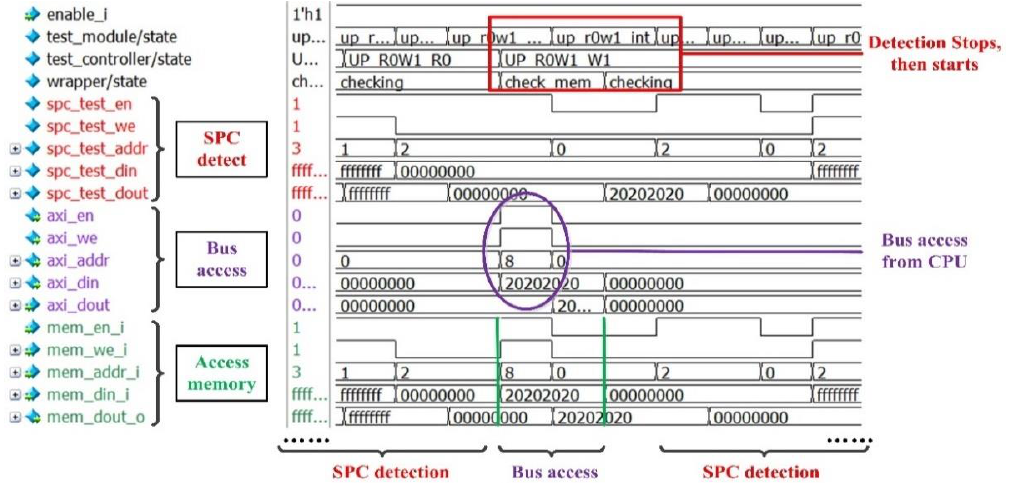
Figure 14. Processing of access collision.